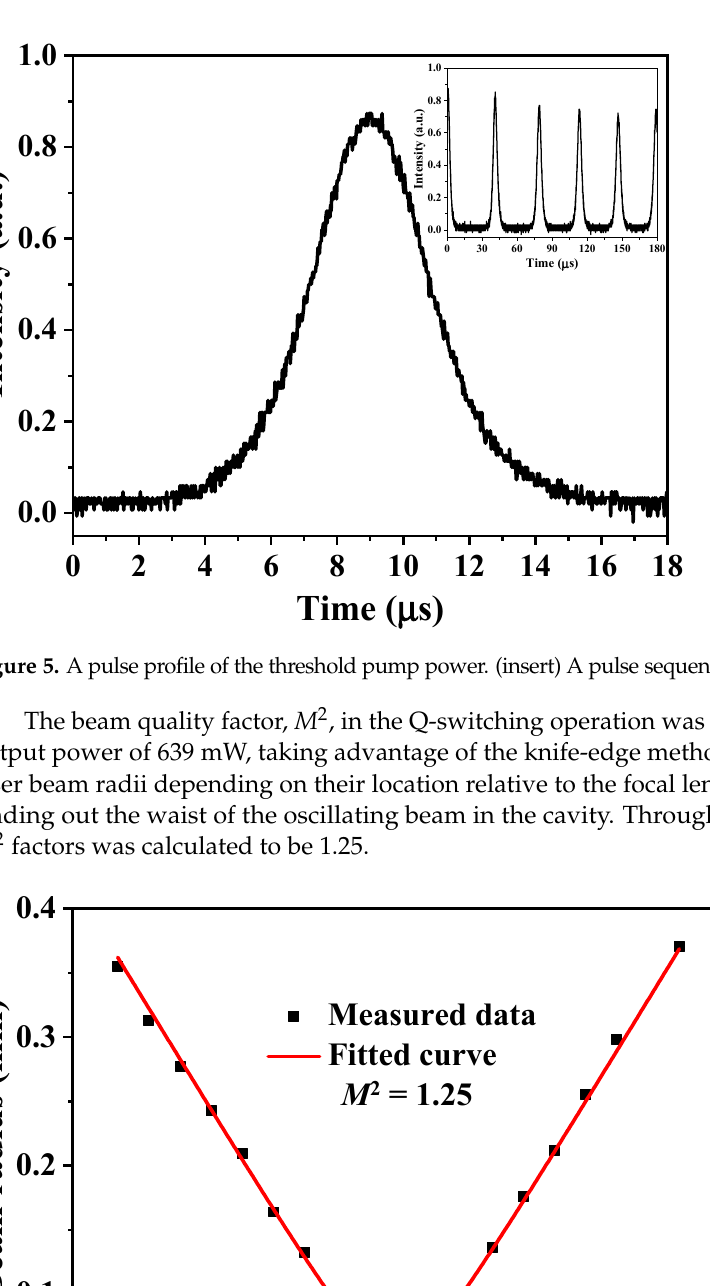
Figure 6. Beam quality of the Q-switched Nd:YAG laser.